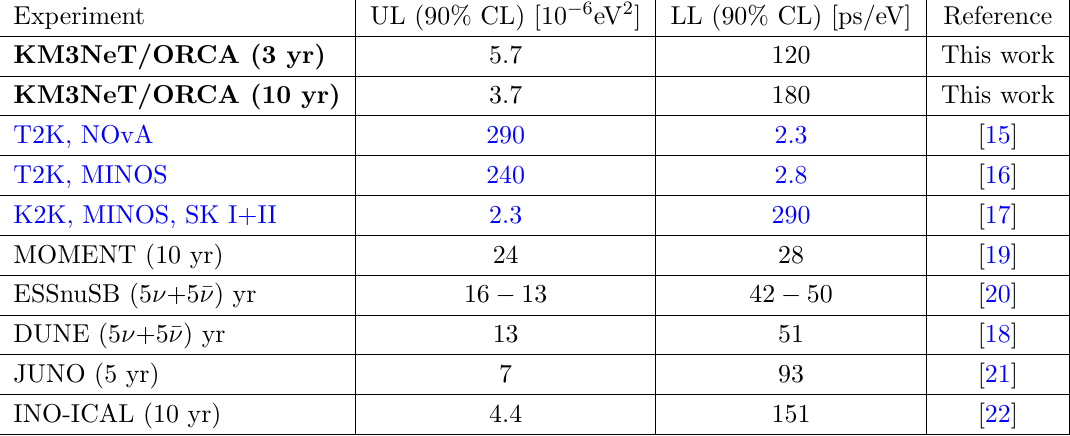
Table 5. Upper limits (UL) and their corresponding conversion into lower limits (LL) at 90% CL for the decay constant, α 3 , and its inverse, 1 /α 3 = τ 3 /m 3 , for current (blue) and future experiments.